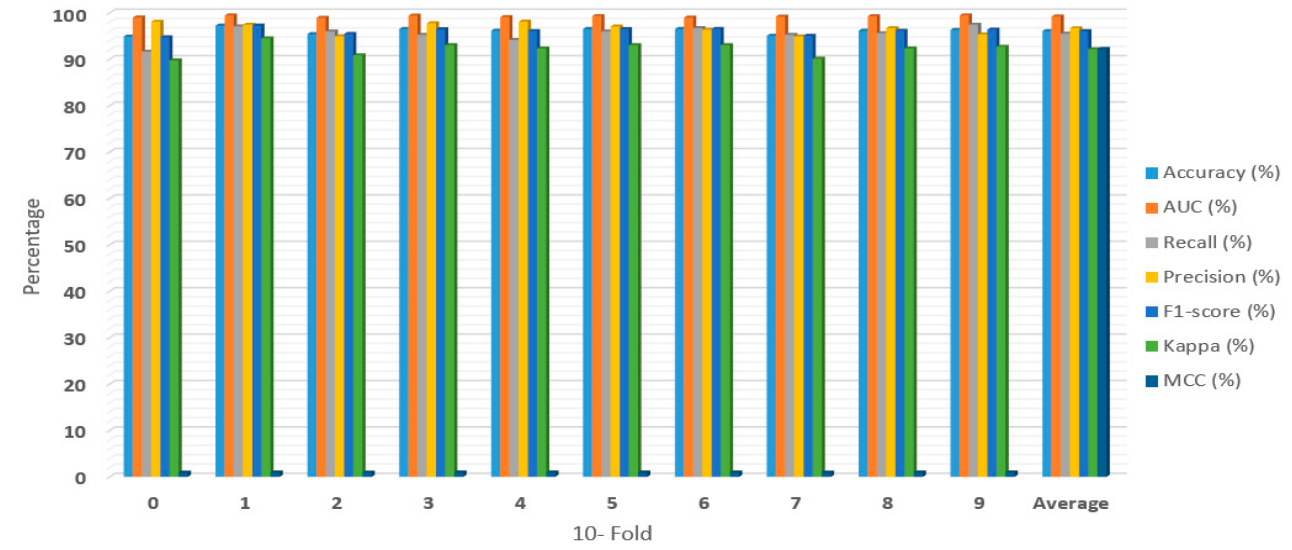
Figure 5. The metrics of the RXLM model before hyper-parameters tuning.